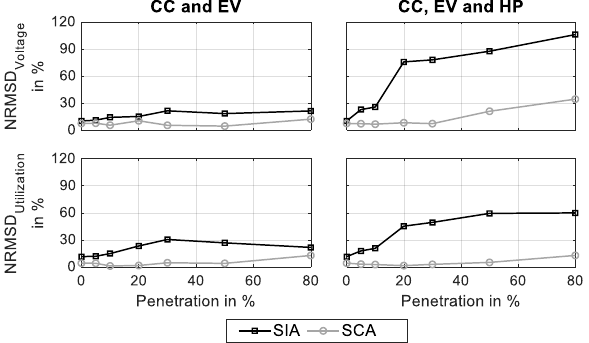
Figure A7. Load approach-induced normalized root mean square deviations (NRMSDs) compared to the TSA in terms of voltage characteristics and thermal utilization considering the rural LV grid.